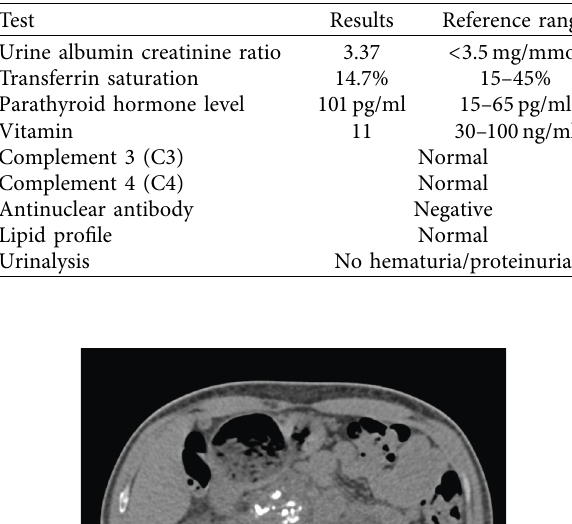
Table 1: Laboratory parameters.